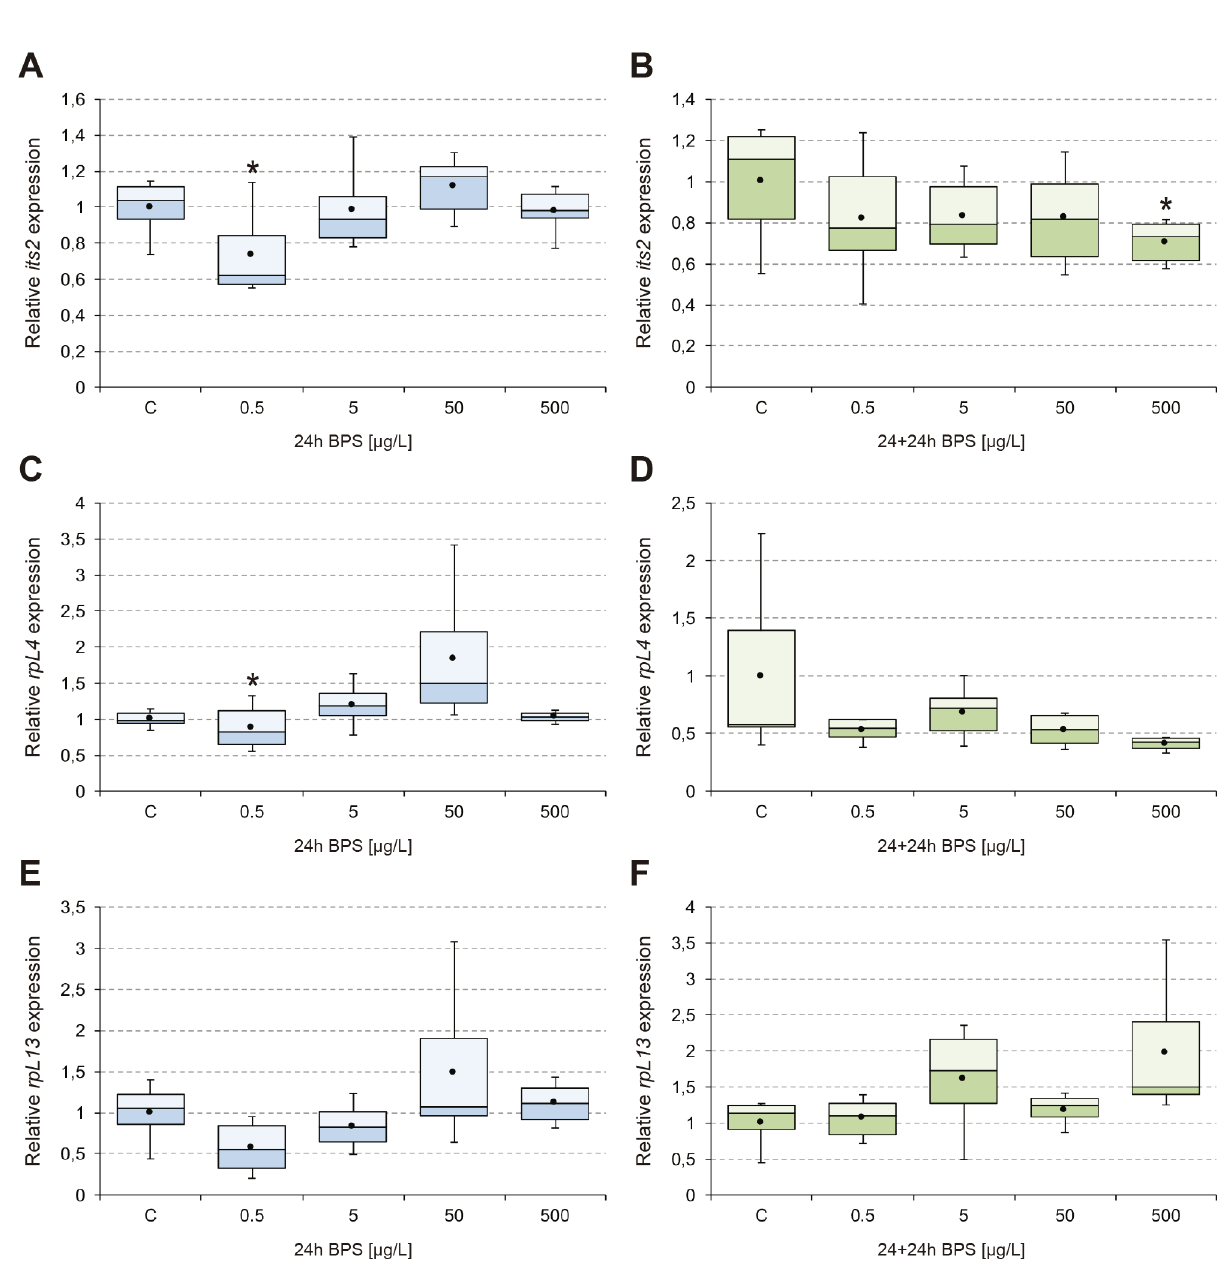
Fig 4. Transcriptional activity of its2 , rpL4 ,and rpL13 . Box-and-whisker plots represent the expression patterns of its2 (A-B), rpL4 (C-D), and rpL13 (E-F), measured by real-time RT-PCR. C . riparius fourth instar larvae were exposed to 0.5–500 μg/L BPS for 24 h (24h; left column; blue series), and maintained for an additional 24 h in fresh culture medium after BPS withdrawal (24+24h; right column; green series). Four independent experiments were performed and RNA was extracted from 5 larvae for each experimental condition (n = 20). Results were normalized to control values. Box and whiskers represent the 25–75 percentile and the minimum/maximum measured values; the mean is represented by a dot; the horizontal line separating the lower (dark) and the upper (light) area represents the median. Asterisks ( (cid:3) ) indicate significant differences (p (cid:20) 0.05) with respect to control values.